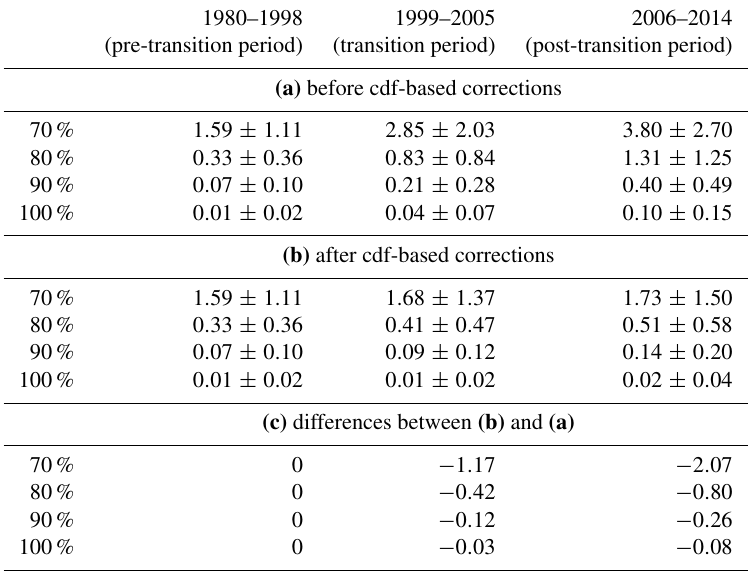
Table 1. Average fraction of exceedances and corresponding standard deviations (both in percent) for UTHi thresholds from 70 to 100% during 1980–1998 (period before the transition from HIRS 2 to HIRS 3/4), 1999–2005 (transition period) and 2006–2014 (post-transition period), before (a) and after (b) application of the cdf-based T 12 intercalibration. Part (c) shows the differences of the means between (b) and (a)